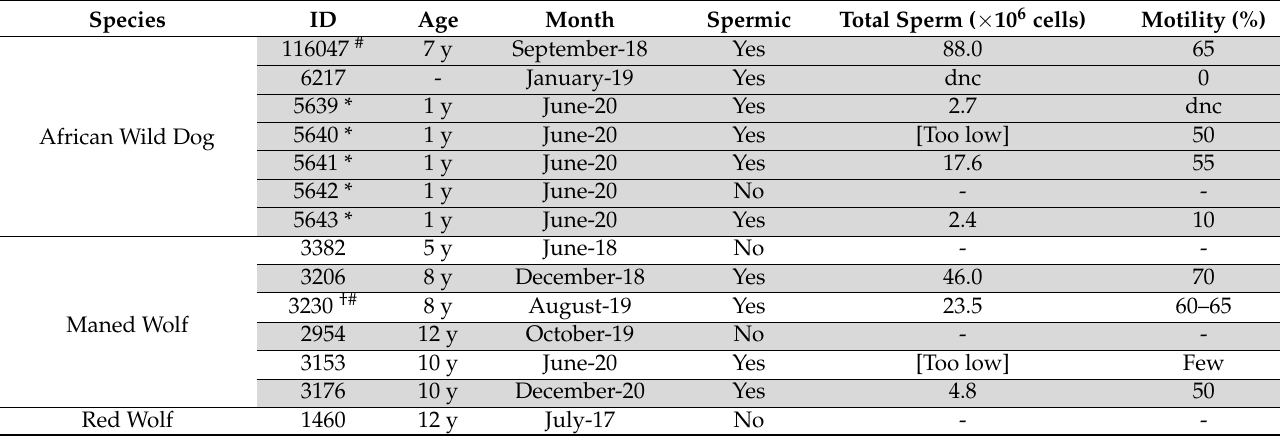
Table 3. Epididymal sperm collection during breeding (grey shading) versus non-breeding (white) seasons ( unpublished data ). dnc = did not